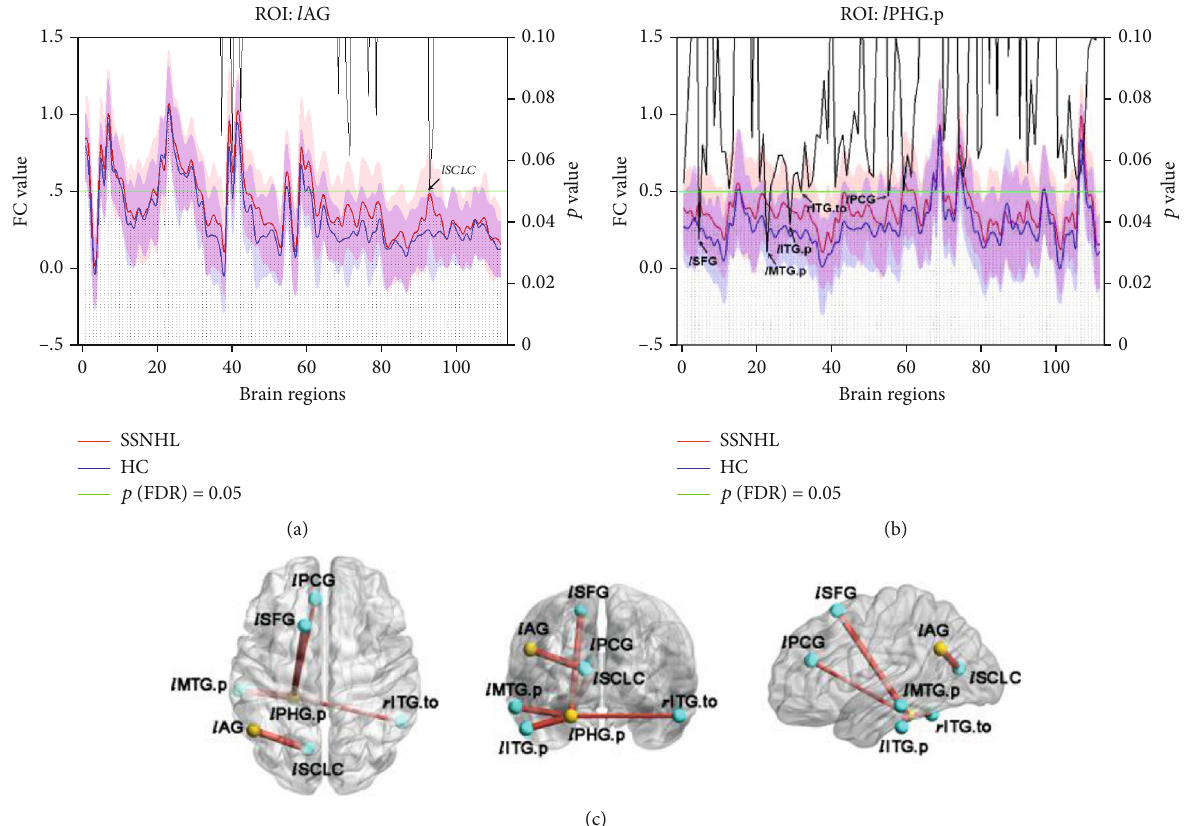
Figure 3: Intergroup comparison of ROI-wise FC between the SSNHL and HC groups. FC between the l AG and l SCLC was signi fi cantly increased (a). FCs between the l PHG.p and ROIs mainly located in the bilateral temporal lobes and left frontal lobe were signi fi cantly increased (b). The x -axis coordinates correspond to the numbers of the brain regions in the Harvard-Oxford Atlas. The y -axis coordinates on the left indicate the FC value, while those on the right indicate the p value. The red and blue curves indicate the mean FC values of the pair of ROIs in each group, and the shadow re fl ects the standard deviations. The black line indicates intergroup di ff erences between each pair of ROIs, with a p value less than 0.05 where the black line is below the green horizontal line. ROI-wise FCs with signi fi cant di ff erence between the SSNHL and HC groups are presented in a node and edge graph (c). The yellow balls indicate the seed ROI, while the cyan balls indicate the ROIs with signi fi cantly di ff erent FC values. The size of the sticks corresponds to the t -values from the two-sample t -tests. SCLC: supracalcarine cortex; PHG: parahippocampal gyrus; SFG: superior frontal gyrus; ITG: inferior temporal gyrus; PCG: paracingulate gyrus; l : left; p: posterior division; to: temporooccipital